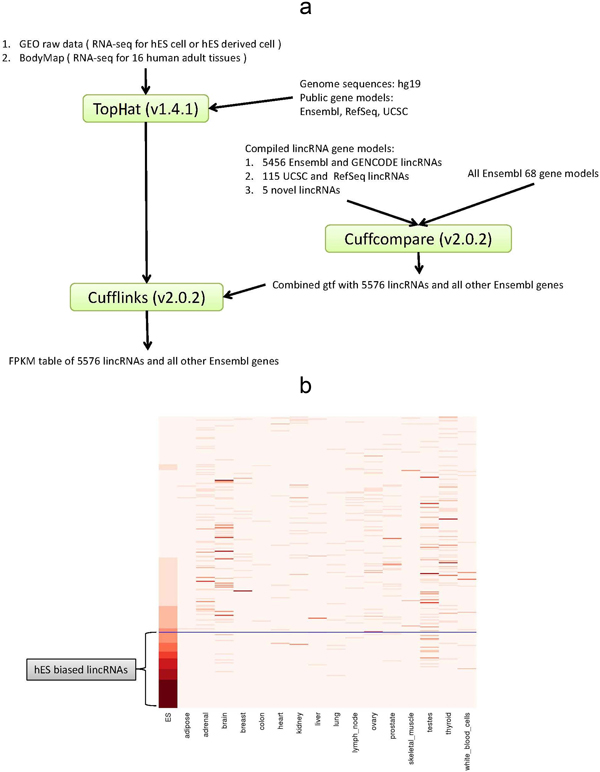
300 hES lincRNAs. (a) The analysis pipeline. We mapped reads onto hg19 human genome using TopHat (v1.4.1) [39] with a reference helped strategy in case of failure to map some junction reads. We merged gene models from different resources using cuffcompare, and calculated gene expression level using Cufflinks (v2.0.2) [17] based on gene models we compiled. (b) Abundance of 300 hES lincRNAs across hES and human adult tissues. Color intensity represents the fractional density across the row of FPKM as estimated by Cufflinks [17]. Classifying by tissue specificity index [46], one fourth (78 out of 300) hES lincRNAs were biasedly expressed in hES (tau > 0.9).